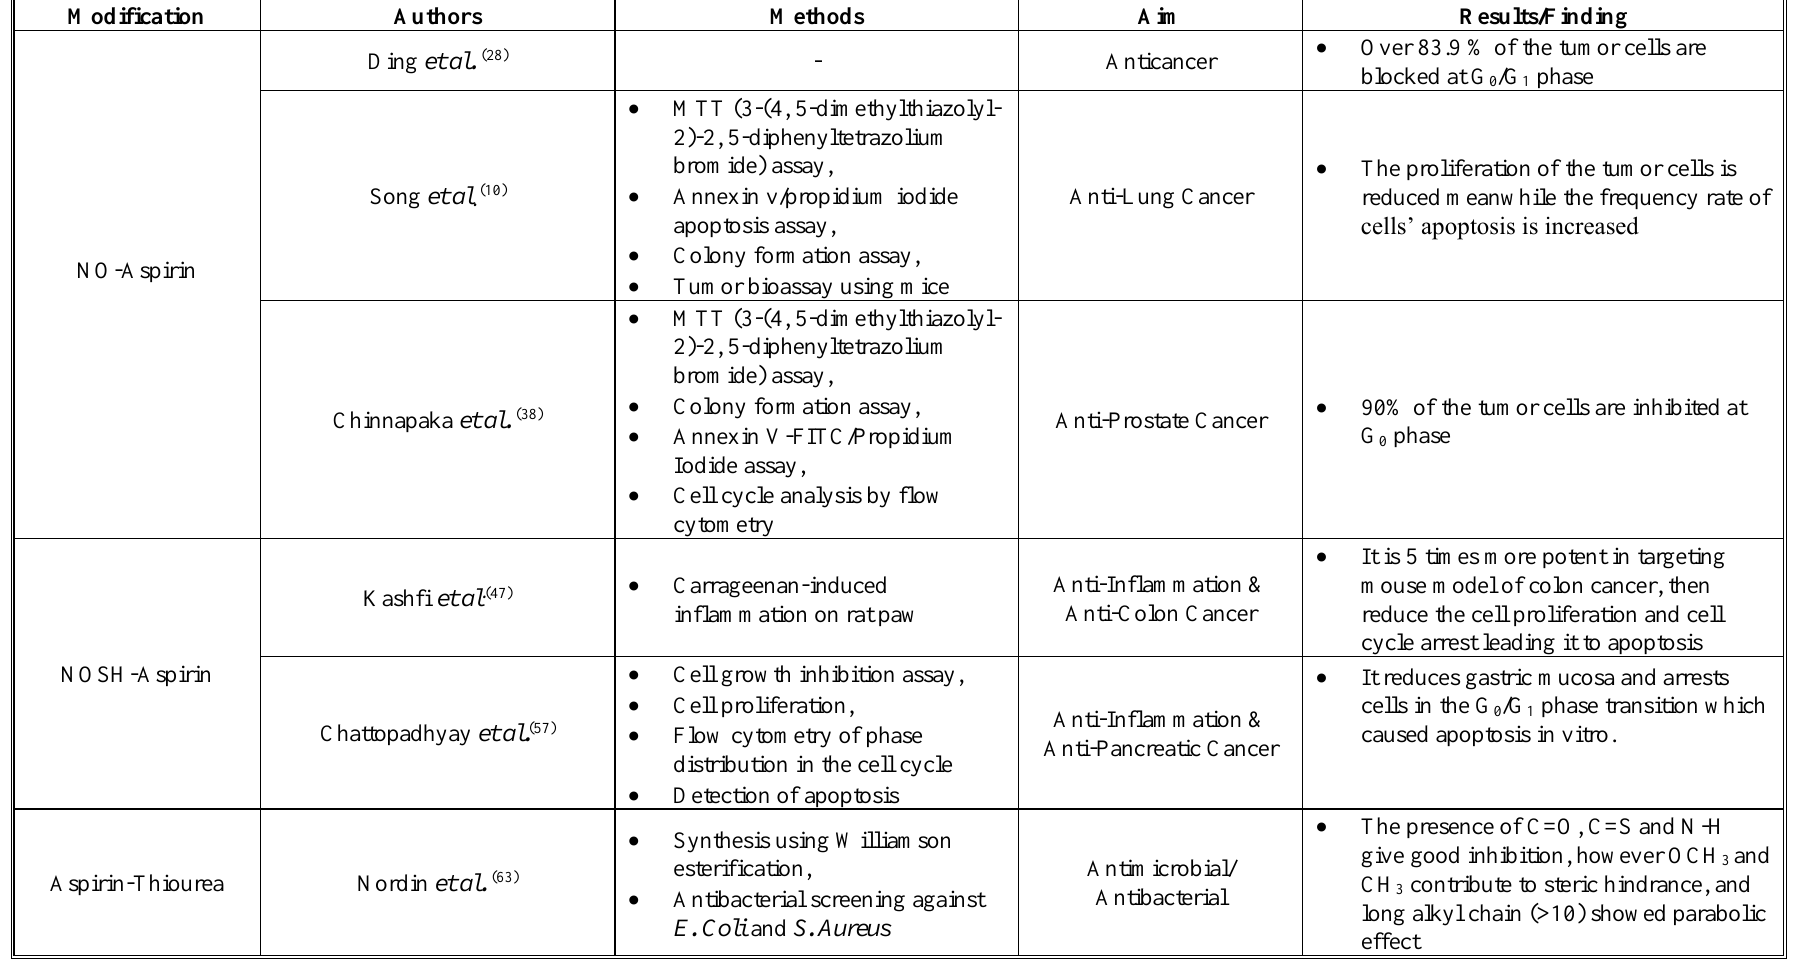
Table (3) Summary of the Aspirin Derivatives and Their Related Biological Activities: